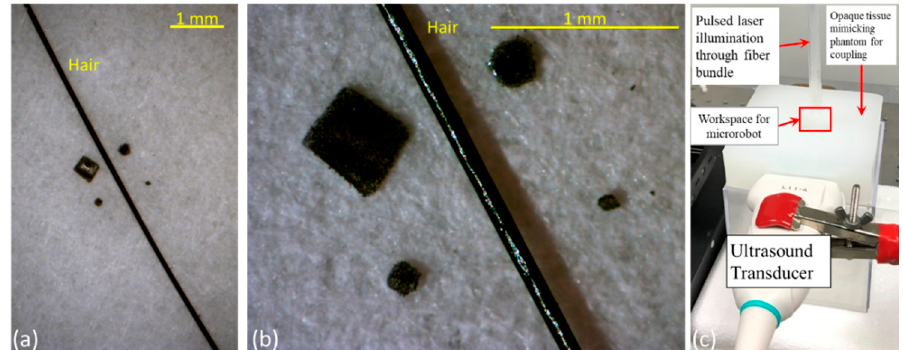
Figure 1. Photograph of the micro-scale microrobots with sizes of 400, 200, 100, and 50 µm at ( a ) no zoom, ( b ) 4 × zoom. ( c ) Experimental setup for the integrated USPA imaging system for tracking microrobots. (The US platform, power source for the laser, and magnet are not shown in the figure).